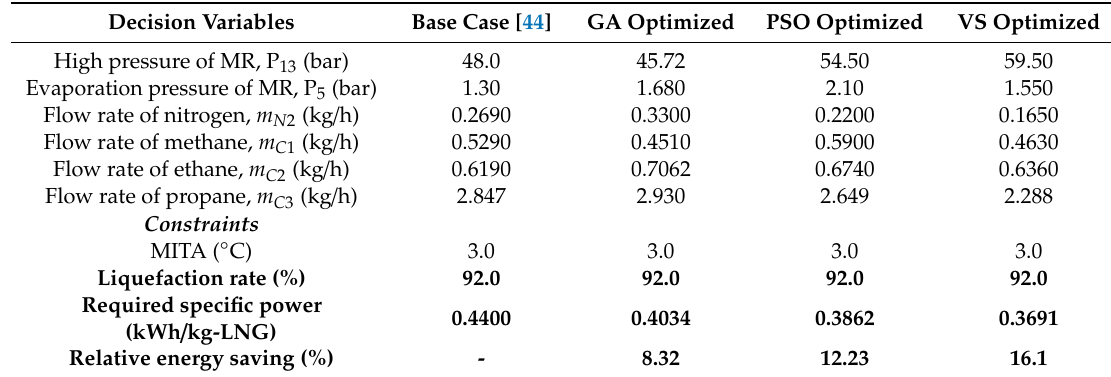
Table 7. Summary and comparison of the optimization results of the VS-optimized SMR with optimized SMR process using other well-known optimization